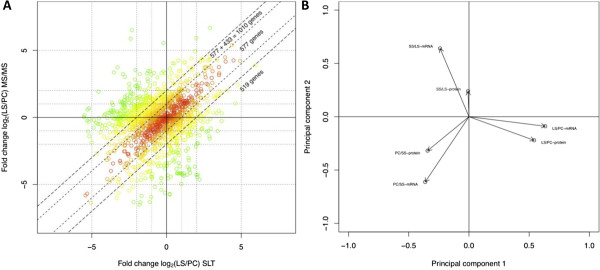
Correlation of mRNA and protein changes between LS and PC T. brucei. (A) Scatter plot comparing RNA (x-axis) and protein (y-axis) change in log2 between LS/PC. The colour of the circles change from red to green based on the correlation. The dashed lines indicate difference in fold-change ≤ 4 fold between RNA and protein. Spearman’s rank correlation rho=0.61 (p-value< 2.2E-16) and Pearson’s product moment correlation is 0.74 (p-value < 2.2E-16). The dotted lines indicate difference in fold-change ≤ 2 fold between RNA and protein. Spearman’s rank correlation rho=0.8339 (p-value< 2.2E-16) and Pearson’s product moment correlation is 0.9 (p-value < 2.2E-16). (B) Correlation and variability of mRNA and protein abundance changes during development based on the first two Principal components (PC).